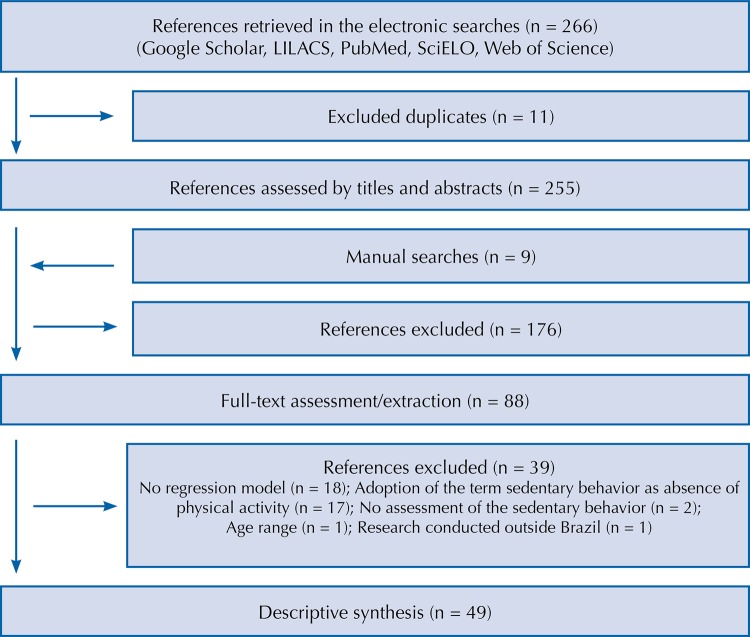
Flowchart of the systematic review.